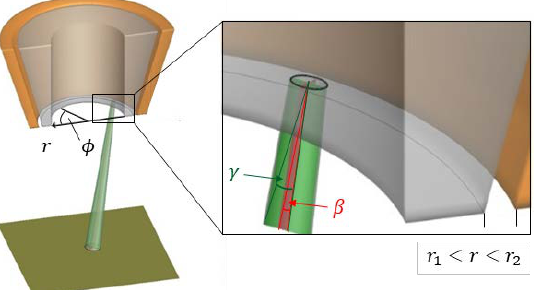
Figure 14. Diagram of the parameters for the particle propagation model. Left: Description of the powder particle density distribution with polar coordinates (r, Φ ). Right: Model parameters for adjusting the angles inclination with respect to the z-axis: β and the x-y-axis: γ [1]. Reprinted with permission from Ref [1]. Copyright 2020, Fraunhofer Verlag.